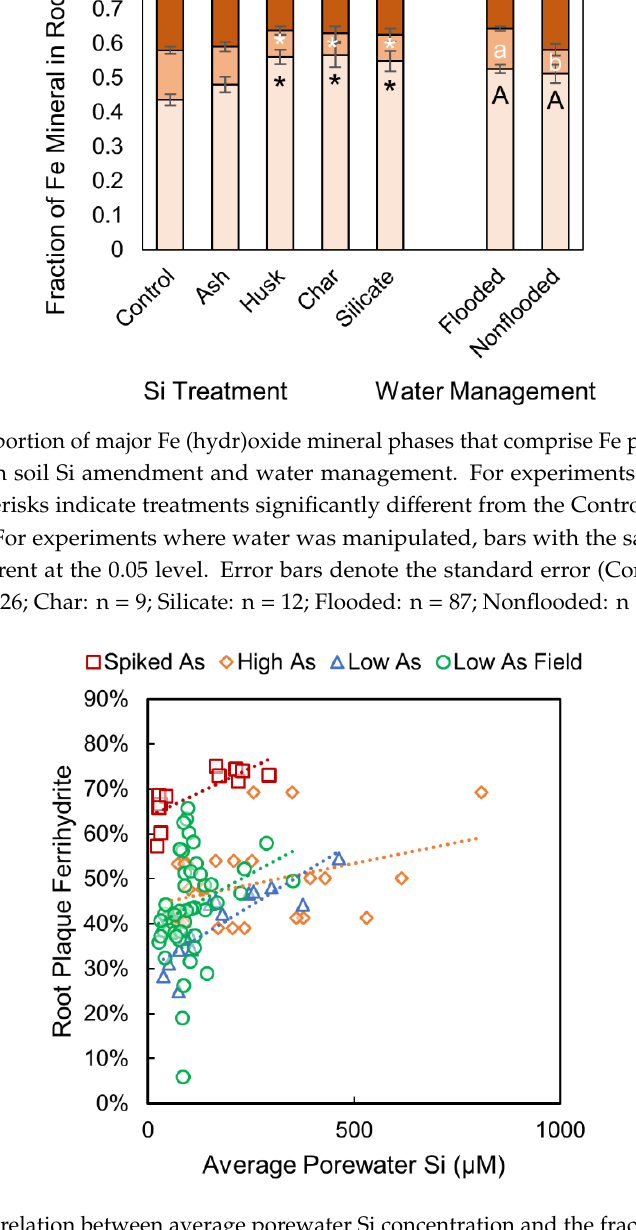
Figure 3. Positive relation between average porewater Si concentration and the fraction of ferrihydrite in the root plaques in all tested pot and field experiments. (Spiked As: R 2 = 0.61, p = 0.0026, n = 12; High As: R 2 = 0.15, p = 0.046, n = 27; Low As: R 2 = 0.74, p < 0.0001, n = 15; Low As Field: R 2 = 0.078, p = 0.057, n = 47).